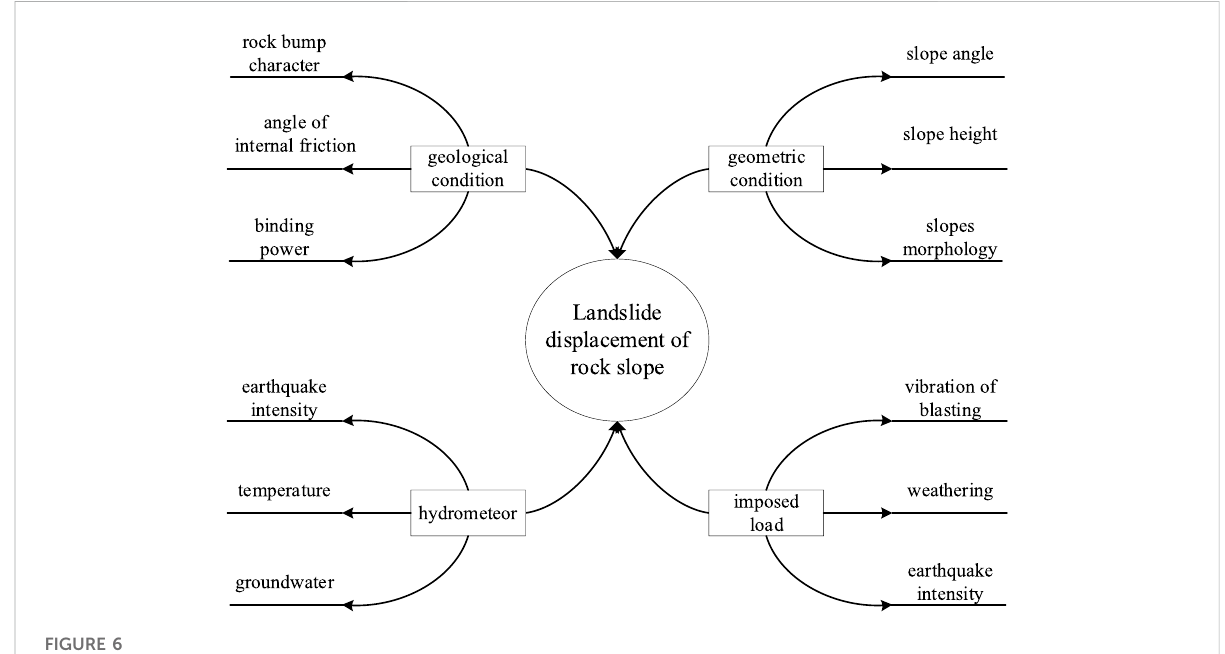
FIGURE 6 Diagram of in fl uence factors of slope and landslide displacement.